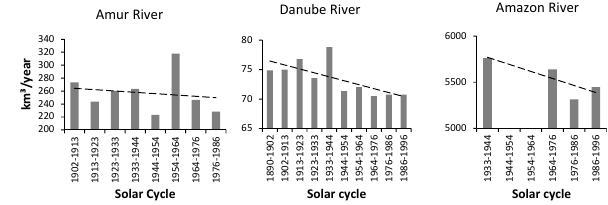
Figure 2. Rivers discharge flowing in sub-latitudinal direction and trends.